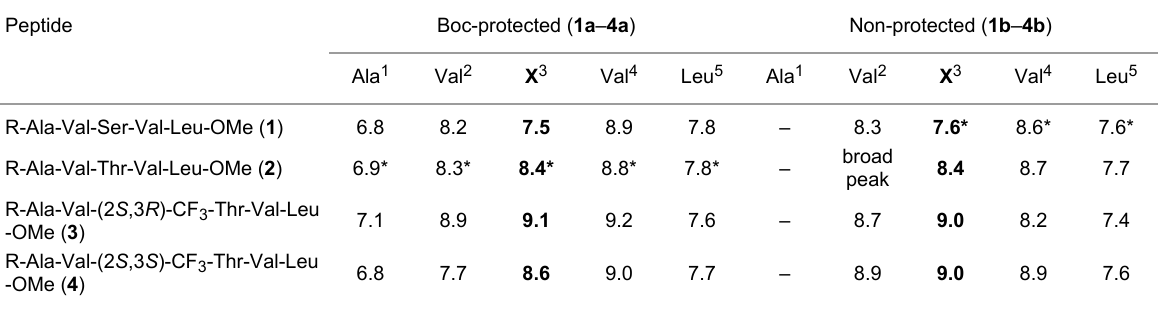
Table 3: Coupling constants 3 J HN–H α (Hz) of residues in pentapeptides 1a – 4a and 1b – 4b in CD 3 OH (271 K for most residues, * indicates values measured at 298 K).